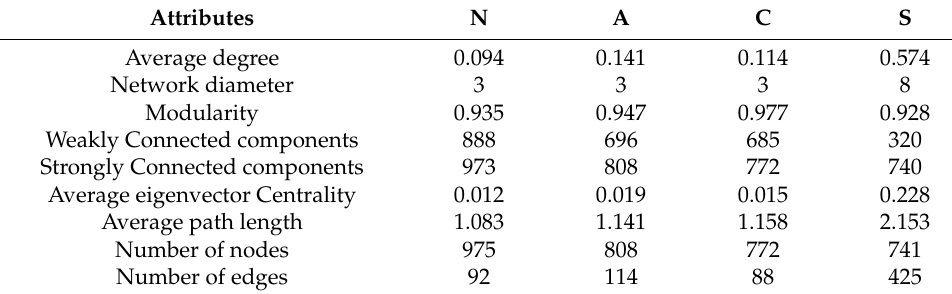
Table 4. The main attributes of the forwarding networks at each